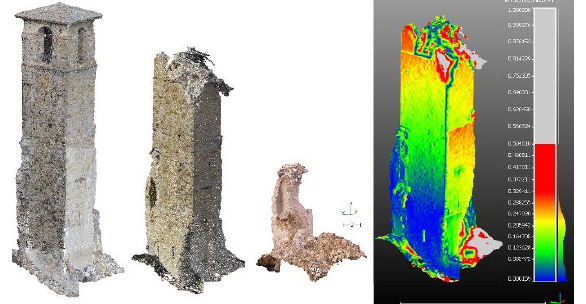
Figure 16. Belfry temporal transformation after reiterated seismic shocks: t1, t2, t3. In range colors comparison between t1-t2 with values 0<v<0.50m (grey for values >0.5m)